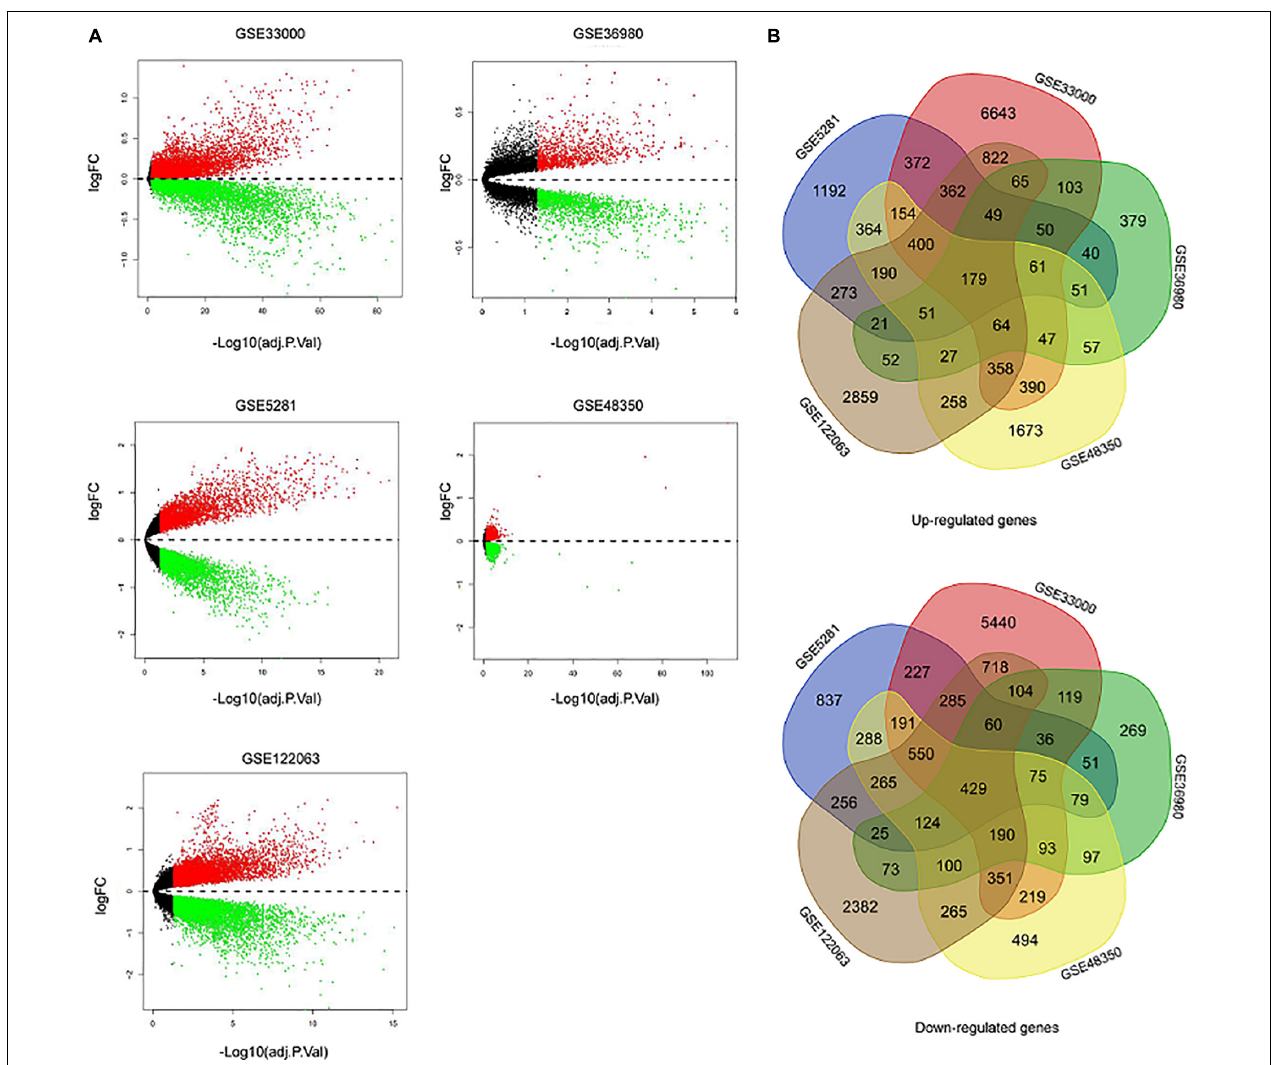
FIGURE 2 | Identification of DEGs between AD and NDHCS samples. (A) The volcano plot of the genes in the five datasets. (B) Venn diagram analysis of common downregulated DEGs and common upregulated DEGs. AD, Alzheimer’s disease; NDHCS, non-demented healthy control